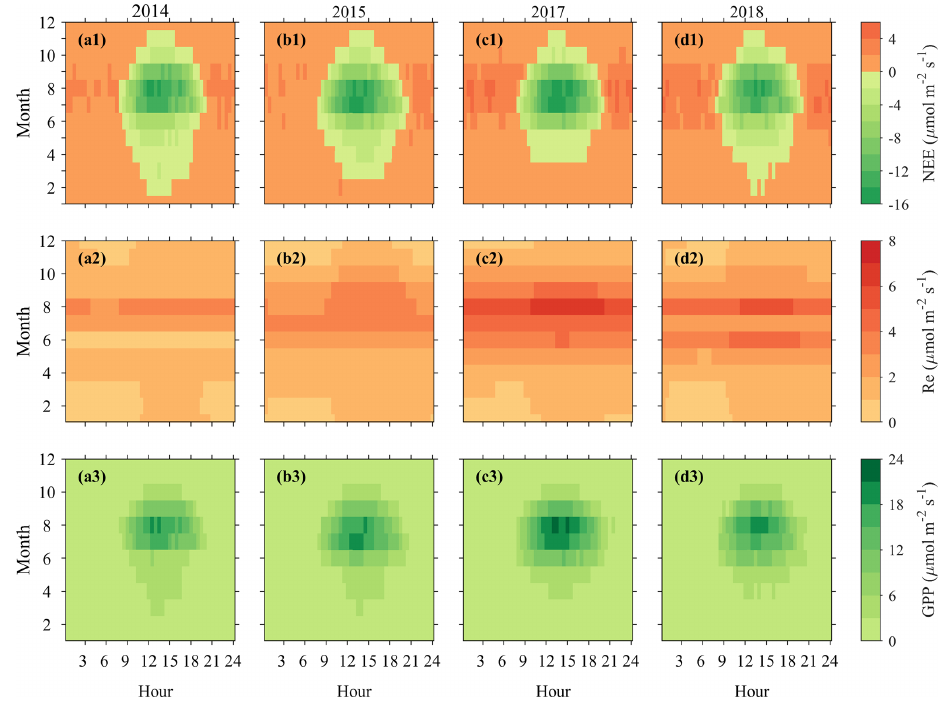
Figure 3. Diurnal variability of gap-filled NEE and partitioned Re and GPP in 2014, 2015, 2017, and 2018.